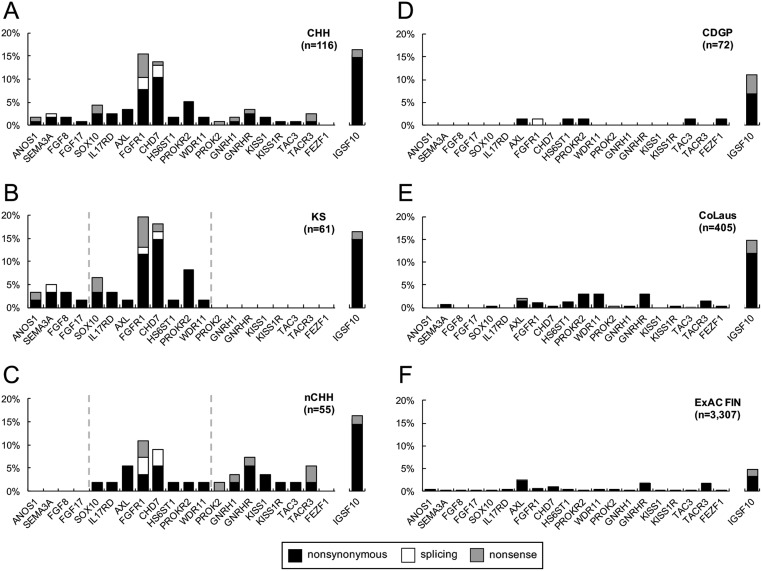
KS and nCHH display both shared and specific genetic patterns, and CDGP is not characterized by genetic overlap with CHH. Histograms showing CHH genes and IGSF10 mutational prevalence in (A) CHH, (B) KS, (C) nCHH, (D) CDGP, (E) CoLaus, and (F) ExAC Finnish (FIN) cohorts. The prevalence of probands with variants in each gene are noted in black for nonsynonymous (i.e. missense and inframe InDels), white for splicing, and gray for nonsense (i.e. frameshift and stop gained) variants.